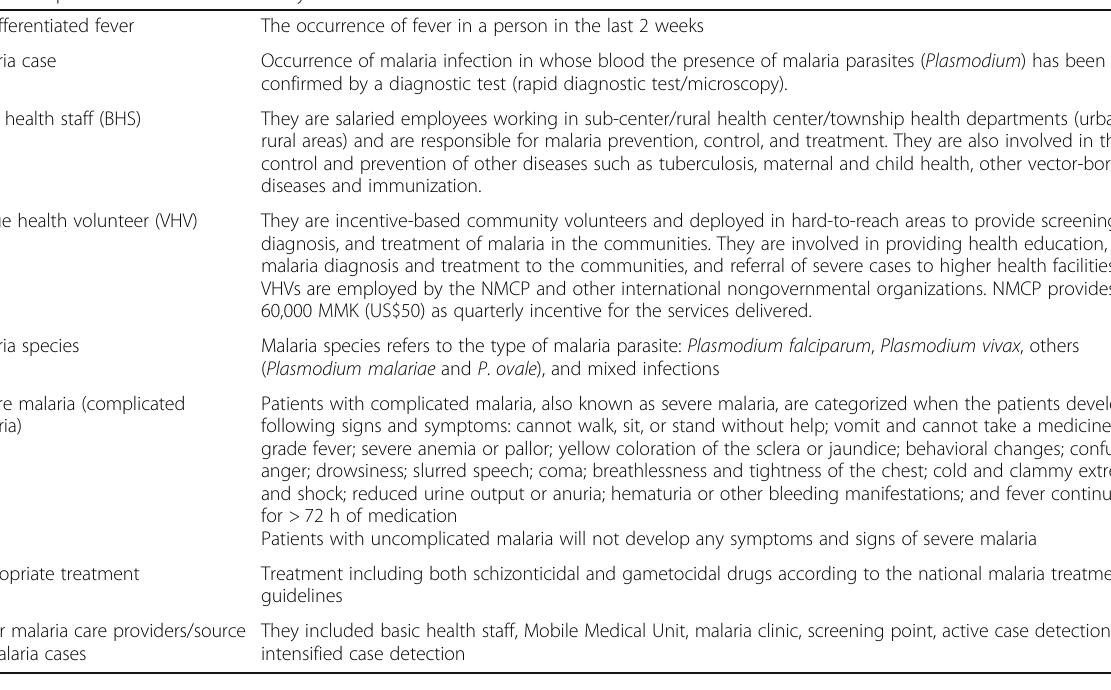
Table 1 Operational definitions of key terms and derived variables Undifferentiated fever The occurrence of fever in a person in the last 2 weeks Malaria